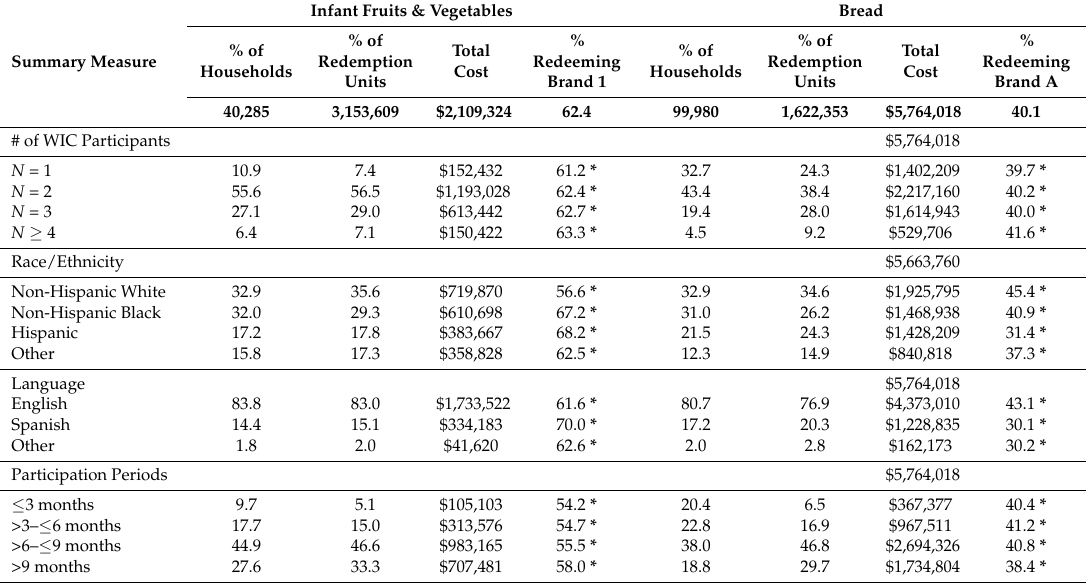
Table 2. Socio-demographics, redemption statistics of WIC participants in Virginia between May 2014 and February